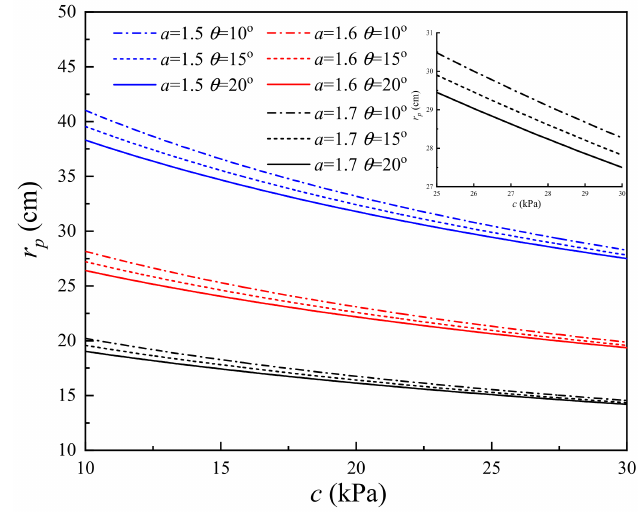
Figure 15. Effect of c on the RSPZ.